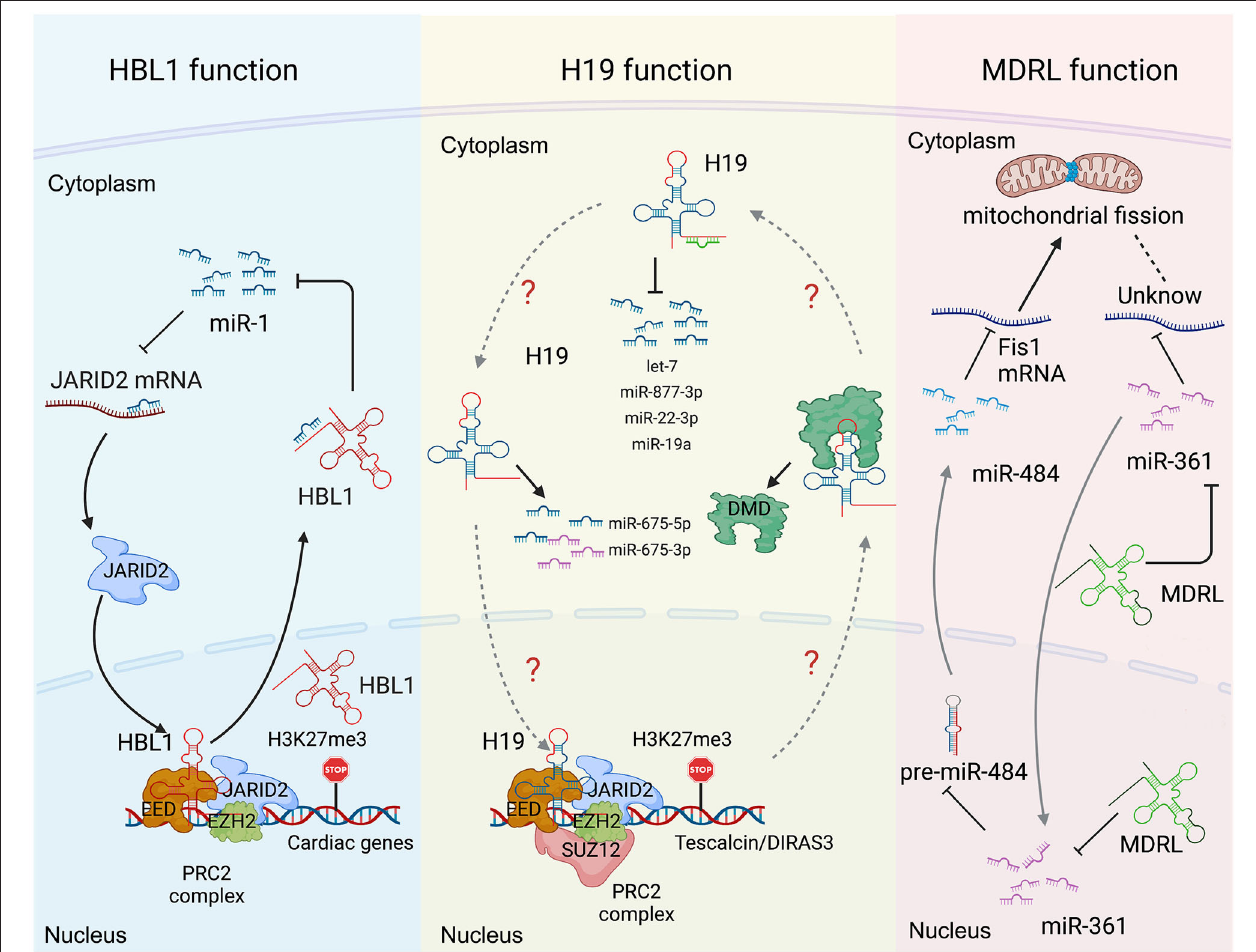
FIGURE 3 | Long non-coding RNA mechanisms cohere with cytoplasm and nucleus in heart development and diseases. (Left) the functions of HBL1 in both cytoplasm and nucleus. (Middle) H19 has multiple functions in both cytoplasm and nucleus. (Right) the functions of MDRL in both cytoplasm and nucleus. Created with